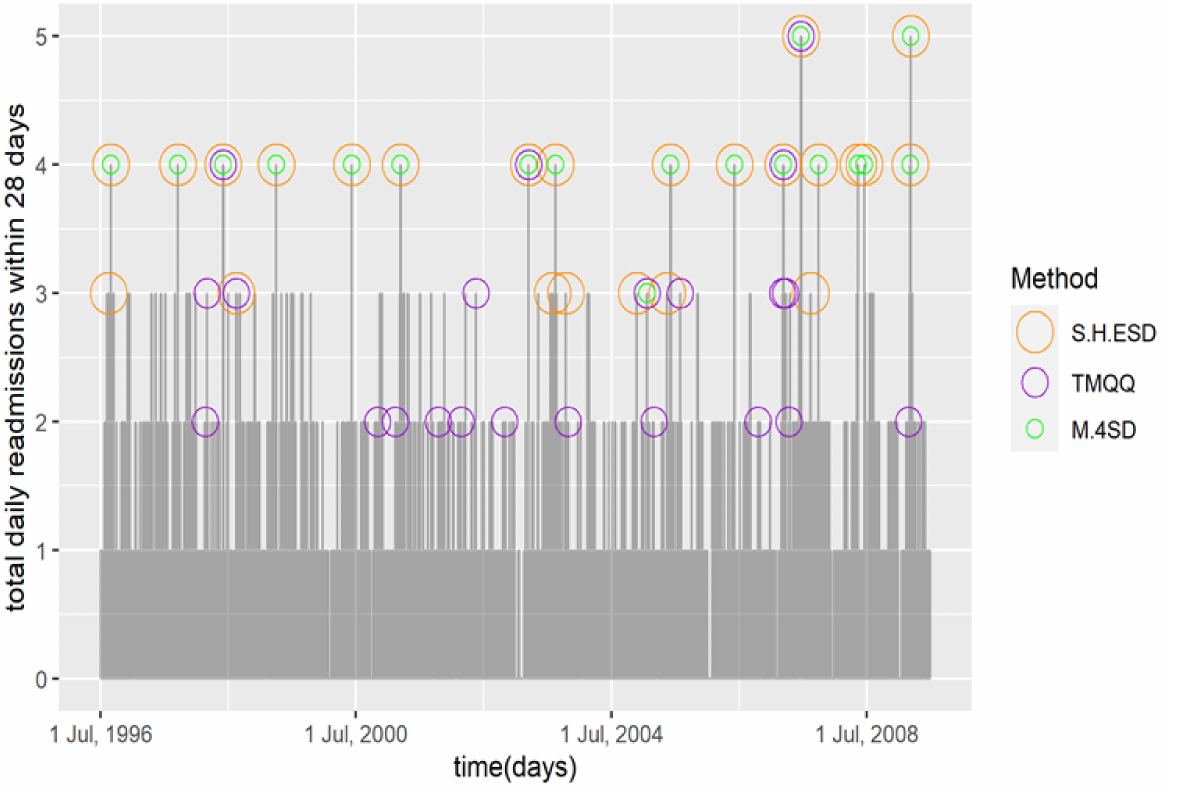
Figure 2. Time series of daily child asthma hospital readmissions within 28 days in Victoria with HARDs classified by the three compared